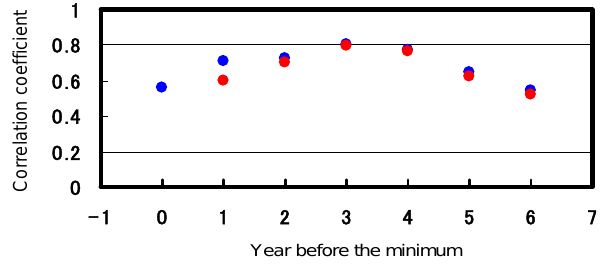
Fig. 5. Blue circles: Correlation coefficient between the maximum sunspot number in the succeeding cycle and the monthly smoothed sunspot number at the minimum and at one, two, three, four, five, and six years before the minimum. Red circles: Correlation co- efficient between the maximum sunspot number in the succeeding cycle and the average rate of decrease of the monthly smoothed sunspot number over a time period of one, two, three, four, five, and six years before the